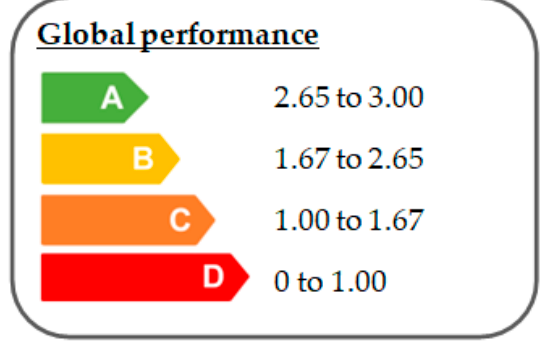
Figure 24. Global performance label.